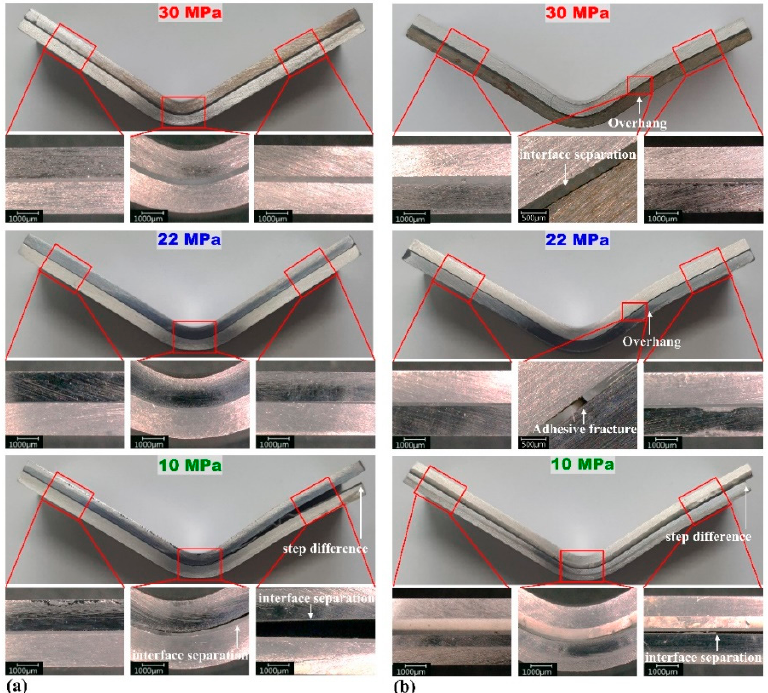
Figure 9. SS330–A5052 multi-material after the flexure test: ( a ) steel (upper)–aluminum (lower) and ( b ) steel (lower)–aluminum (upper). The white arrow indicates adhesive fracture, interface separation, or step difference.